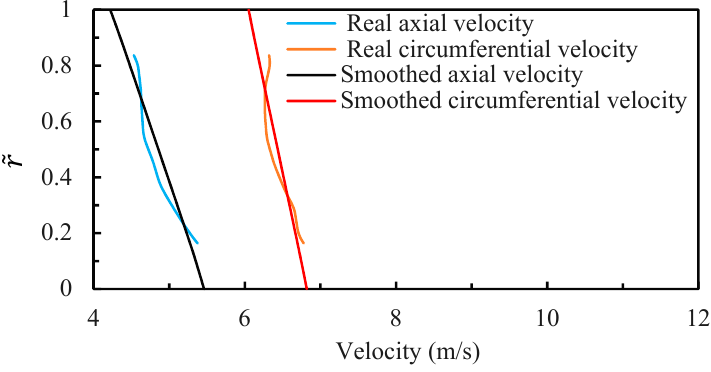
Figure 9. Velocity distribution at the impeller outlet and diffuser inlet. Table 4. Performance comparison between computational fluid dynamics (CFD) calculation and response surface method (RSM) prediction.